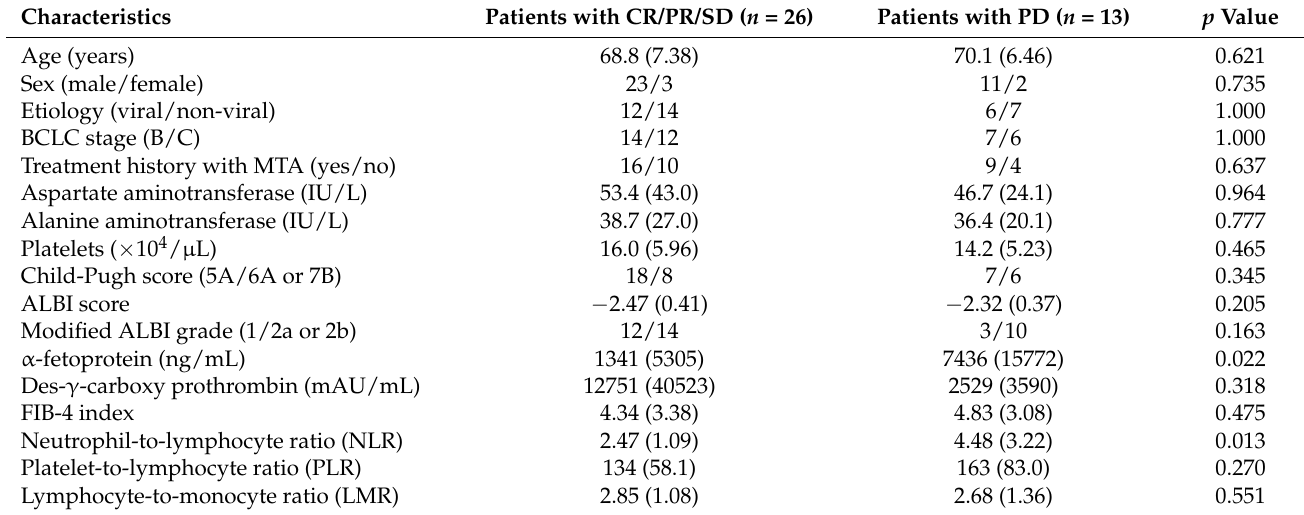
Table 3. Comparison of pretreatment factors between groups of patients who achieved disease control with atezolizumab plus bevacizumab combination therapy and those who did not.